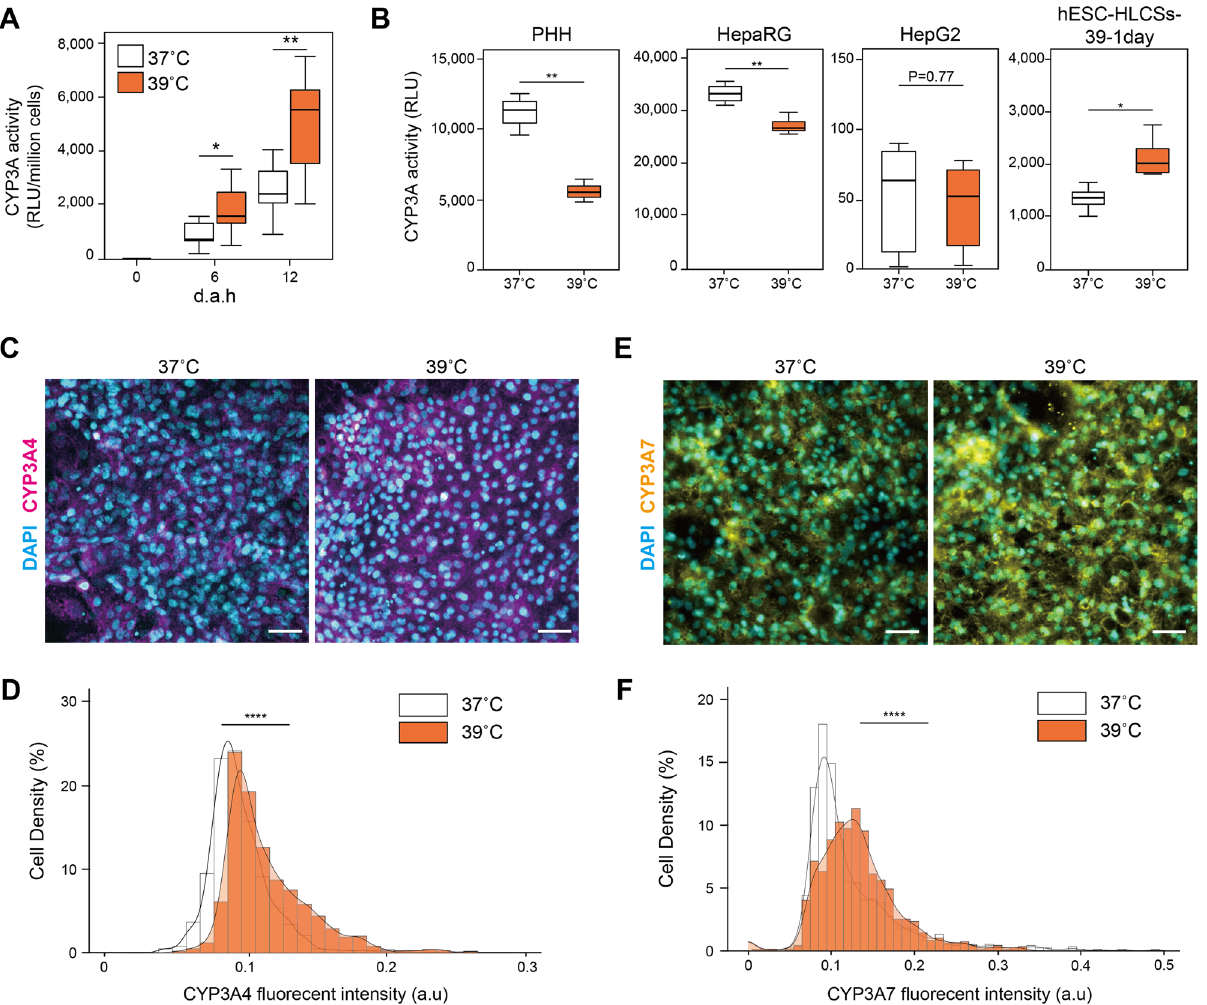
Figure 2. Evaluation of expression of hepatic metabolic CYP enzymes in hESC-HLCs with heat treatments. ( A ) Bioluminescent-based CYP3A activity assay to confirm CYP3A activities during the hepatic differentiation process (n = 7). ( B ) Bioluminescent-based CYP3A activity assay to confirm CYP3A activities of hepatocytes cultured under 39 °C for a day (n = 3). ( C,D ) Immunofluorescent micrographs ( C ) and single-cell profiling ( D ) of CYP3A4 in 37 °C- and 39 °C-treated hESC-HLCs at 12 d.a.h. (n = 3). ( E,F ) Immunofluorescent micrographs ( E ) and single-cell profiling ( F ) of CYP3A7 in 37 °C- and 39 °C-treated hESC-HLCs at 12 d.a.h. (n = 3). DAPI was used for nuclei staining. Scale bars = 50 µm. * p < 0.05, ** p < 0.01, **** p < 0.001, each plot and error bar represents a mean ±